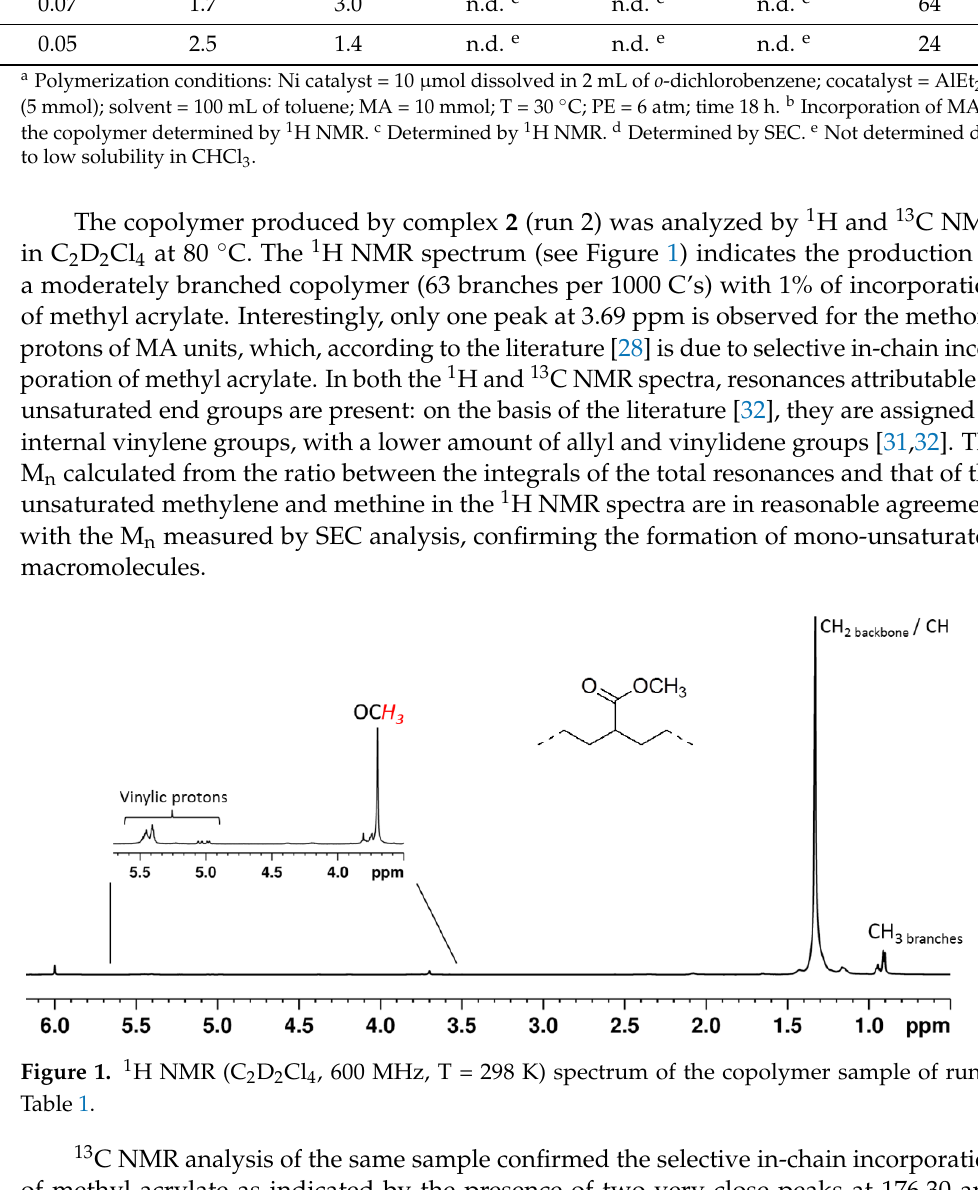
Table 1. Ethylene-Methyl Acrylate Copolymerizations by Complexes 1 − 5 under 6 atm of Ethylene a .